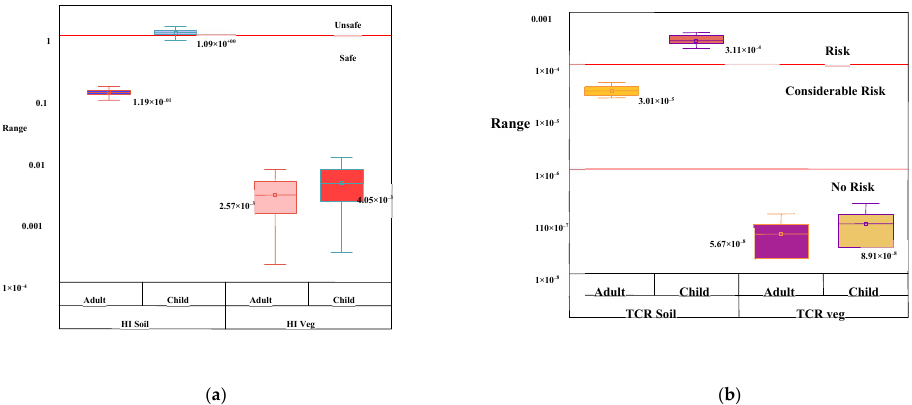
Figure 5. ( a ). Box-whisker plot showing Hazard Index for the assessment of non-carcinogenic risk by the studied heavy metal contaminated soil in adults and child direct and indirect path way. ( b ). Box-whisker plot showing total carcinogenic risk by the carcinogen present in the soil in adults and child by direct soil exposure and via vegetable consumption.